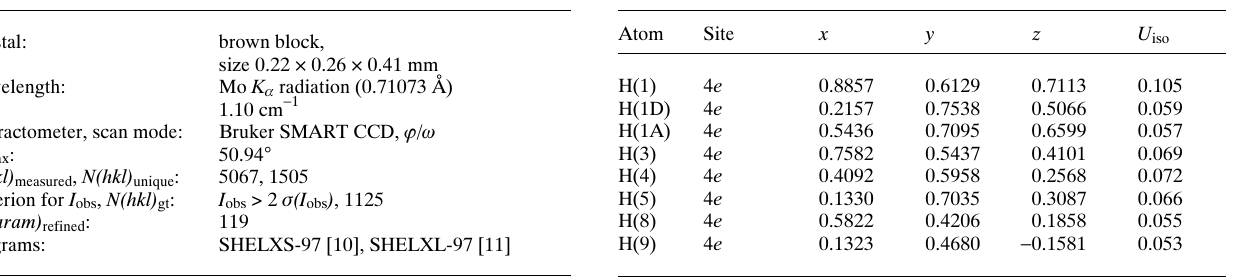
Table 2. Atomic coordinates and displacement parameters (in Å 2 ) . Table 1. Data collection and